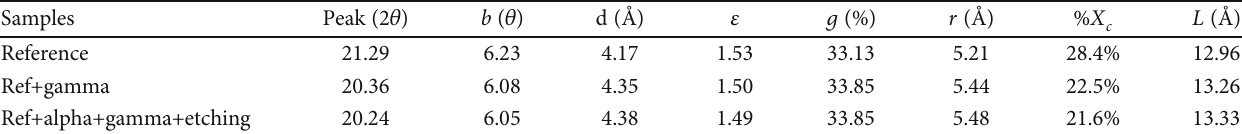
Table 2: Parameters extracted from XRD analysis.